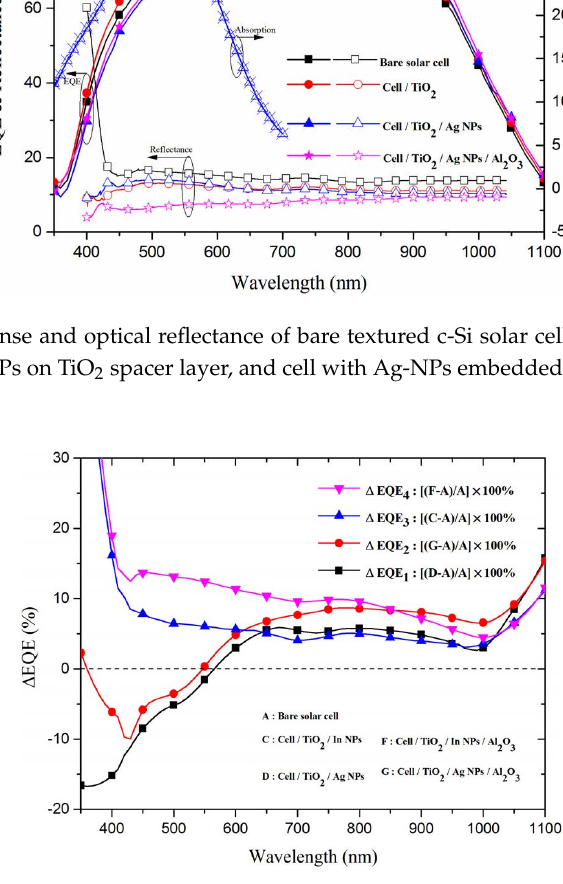
Figure 8. EQE enhancements ( ∆ EQE) of cell with In-NPs on TiO 2 spacer layer, cell with Ag-NPs on TiO 2 spacer layer, cell with In-NPs embedded in the TiO 2 /Al 2 O 3 , and cell with Ag-NPs embedded in TiO 2 /Al 2 O 3 .